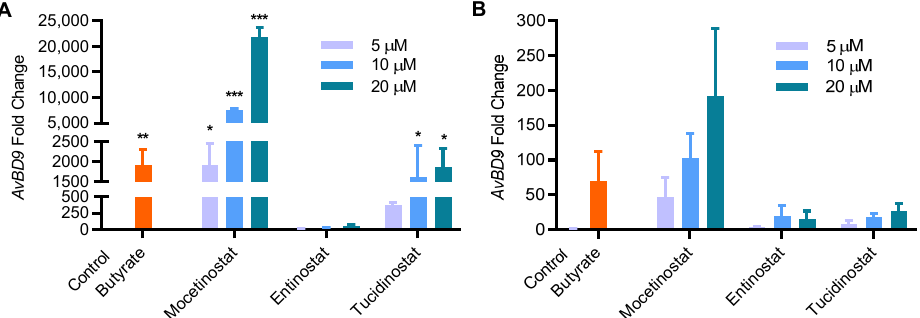
Figure 5. Induction of AvBD9 mRNA expression by mocetinostat, entinostat, and tucidinostat in HTC cells and chicken jejunal explants. HTC cells ( A ) or chicken jejunal explants ( B ) were exposed to 4 mM butyrate or three different concentrations of mocetinostat, entinostat, and tucidinostat for 24 h, followed by analysis of AvBD9 gene expression using RT-qPCR. The results are means ± SEM of 2–3 independent experiments. One-way ANOVA was performed, followed by Dunnett’s test. * p < 0.05, ** p < 0.01, and *** p < 0.001 (relative to the unstimulated control).